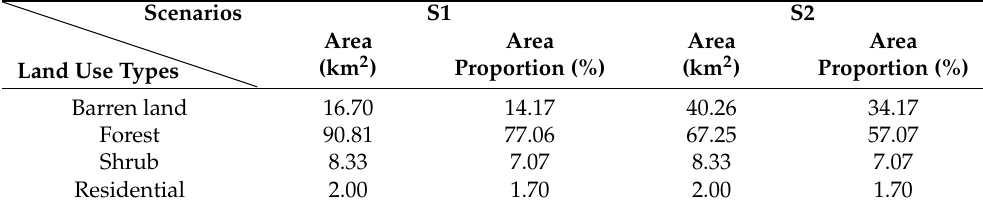
Table 3. The areas of different land use types for S1 and S2. TypesScenarios Land Use Barren